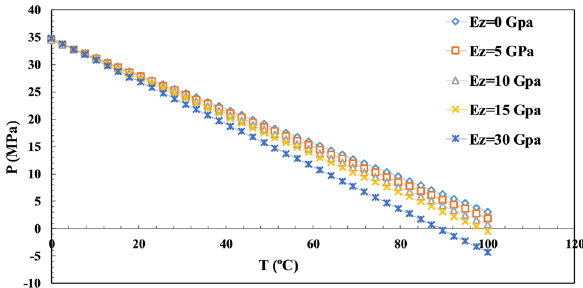
Fig. 18 Effect of longitudinal elasticity modulus of the composite patch on the burst pressure of the repaired pipe